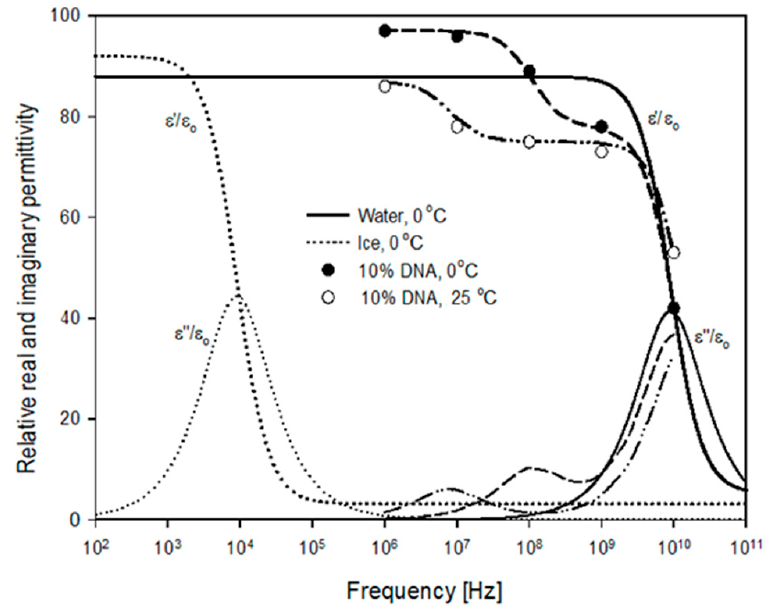
Figure 1. Dielectric constant ( ε ’) and loss factor ( ε ”) spectra of water and ice at 0 °C and with digitized and modeled spectra of DNA solution at 0 and at 25 °C [66] .